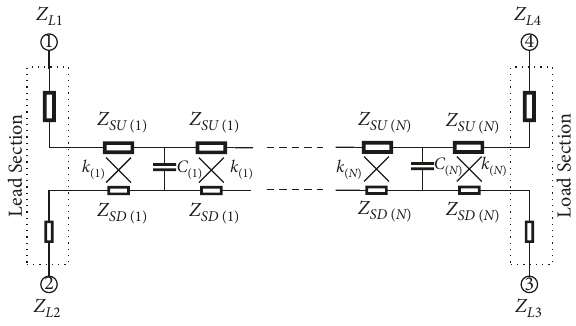
Figure 6: Schematic of multi section asymmetrical transdirectional coupler with capacitance shunt load.